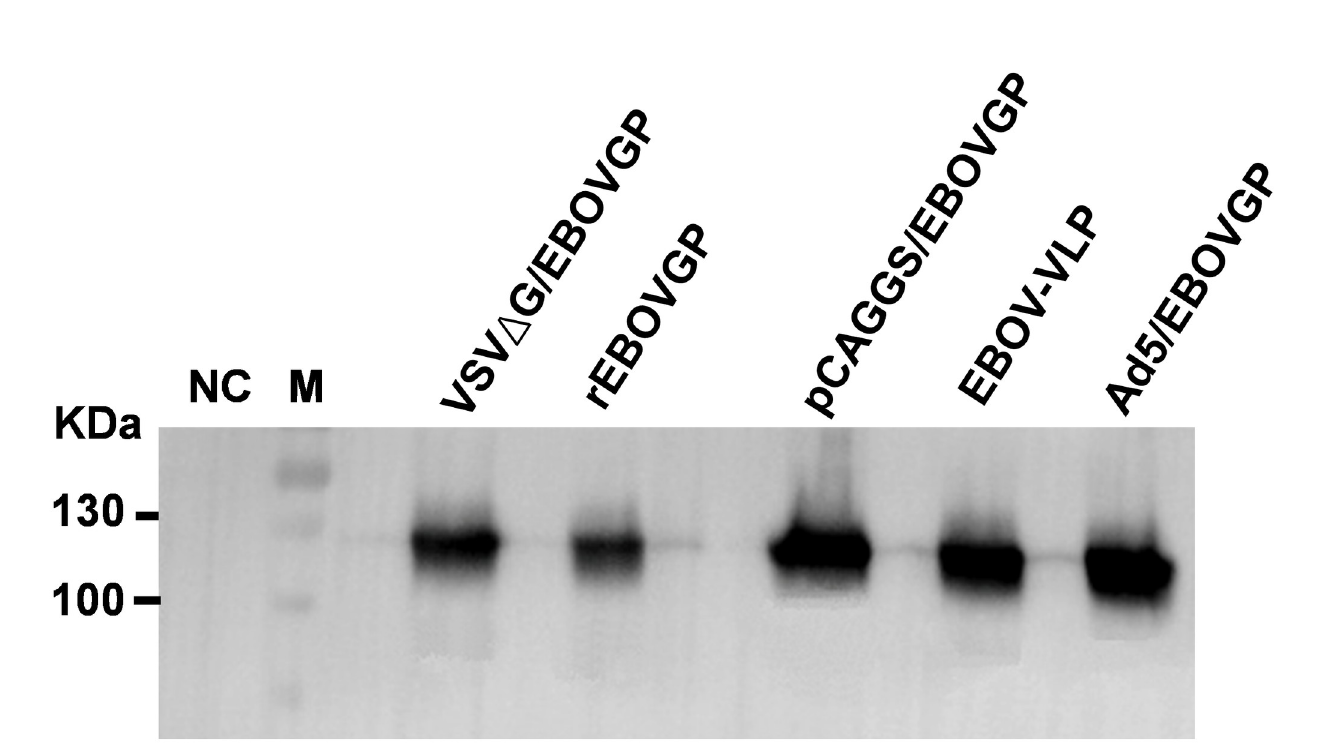
Fig 1. Western blot analysis of EBOV immunogens. Subunit (rEBOVGP, EBOV-VLP), vector (VSV Δ G/EBOVGP, Ad5/EBOVGP) immunogens and 293T cell lysates transfected with plasmid expressing EBOV GP (pCAGGS/EBOVGP) were separated by SDS–PAGE under reducing conditions, transferred to PVDF membrane, and detected using EBOV GP1-specific mAb. Lane NC is 293T cell lysates transfected with pCAGGS plasmid.